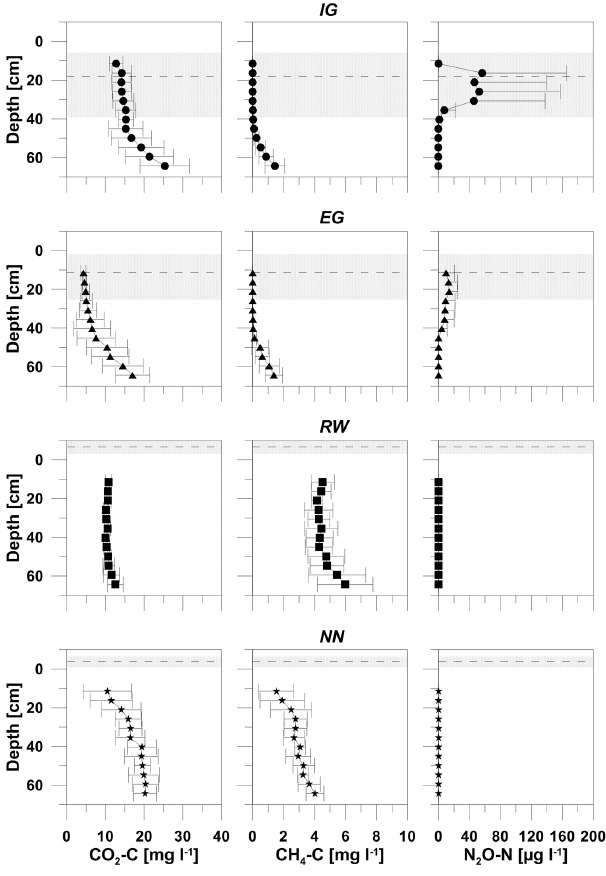
Fig. 7. Concentrations of the dissolved gases CO 2 –C (left), CH 4 – C (centre) and N 2 O–N (right; mean values per depth and standard deviation). The dashed lines represent the mean water table and the dotted area represents the amplitude of the water table fluctuation during the gas sampling period (November 2012–February